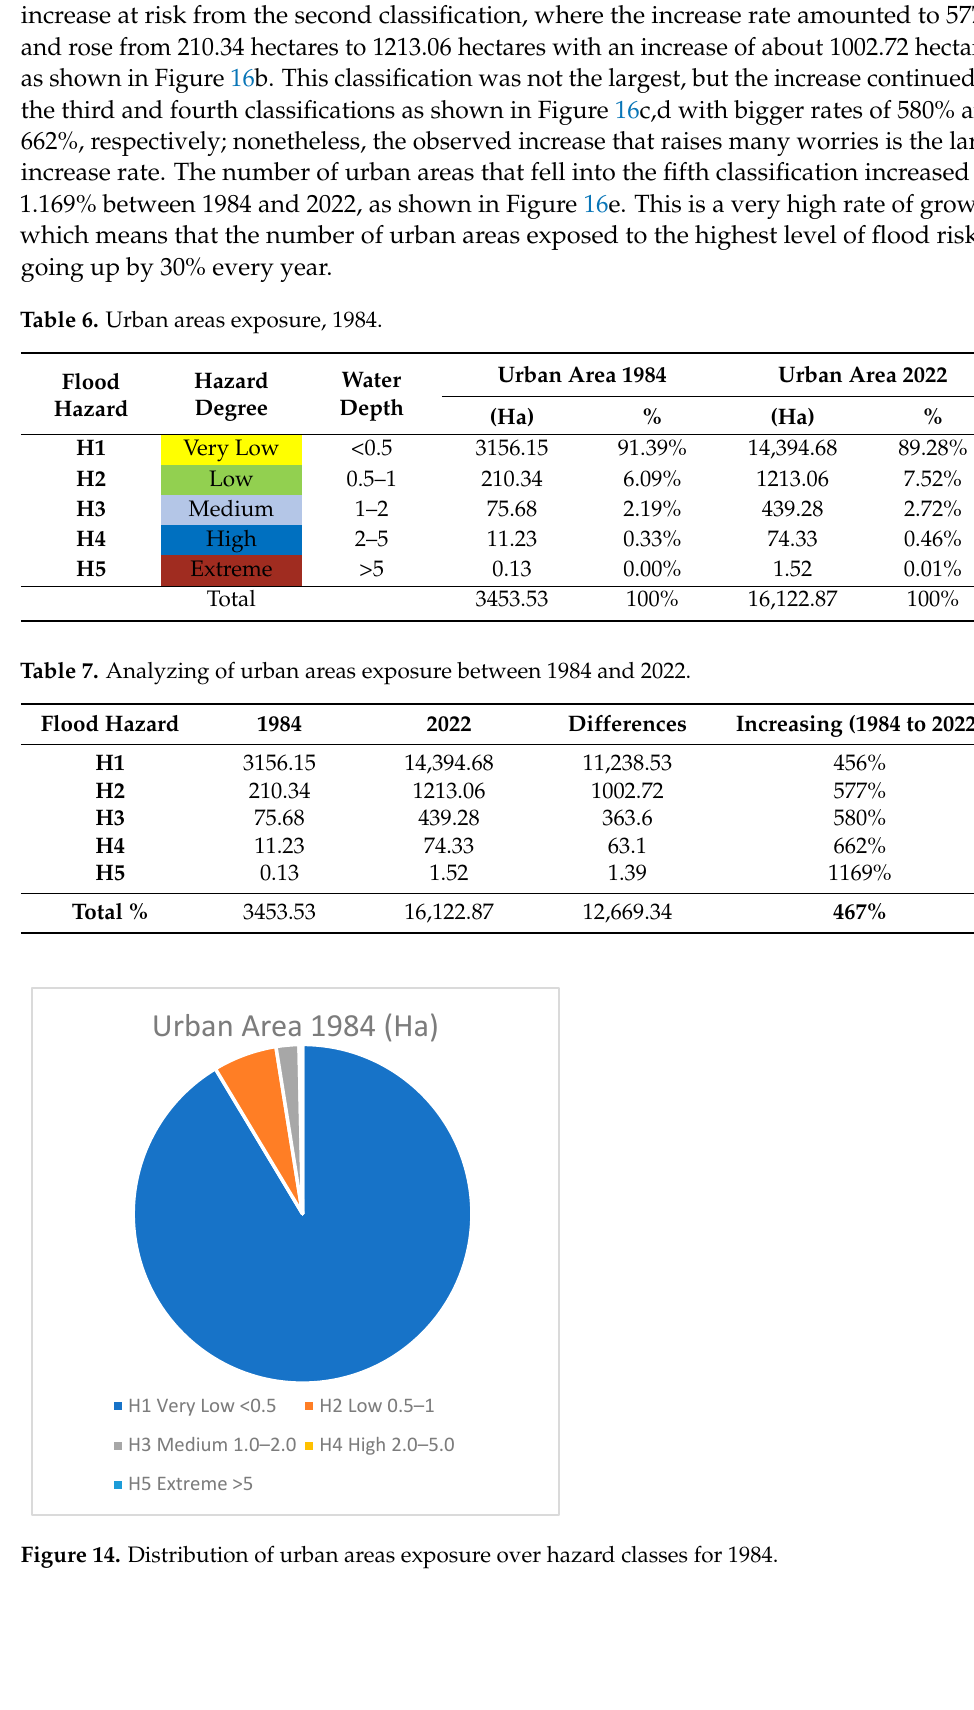
Figure 15. Distribution of urban areas exposure over hazard classes for 2022. In this part of the research, the results have been presented to illustrate the compari- son between the exposure of urban areas in 1984 to the risks of floods and simulating the same conditions if they were repeated in 2022 after a large urban growth. The most im- portant part of the comparison was the study of changes in urban areas in each classifica- tion individually. Figures 14 and 15 show some crucial information, the most crucial of which is that between 1984 and 2022, the rate of urbanization increased at a rate of about 467%. However, closer examination reveals that this percentage precisely reflects the rise in urban areas that are susceptible to flash flooding risks in the first classification, which was only 456%. This is made abundantly clear in Figure 16a, whereas the rest of the clas- sifications exhibited a significant degree of variation in the rates of increase, and this can be seen in the urban increase at risk from the second classification, where the increase rate amounted to 577% and rose from 210.34 hectares to 1213.06 hectares with an increase of about 1002.72 hectares as shown in Figure 16b. This classification was not the largest, but the increase continued in the third and fourth classifications as shown in Figure 16c,d with